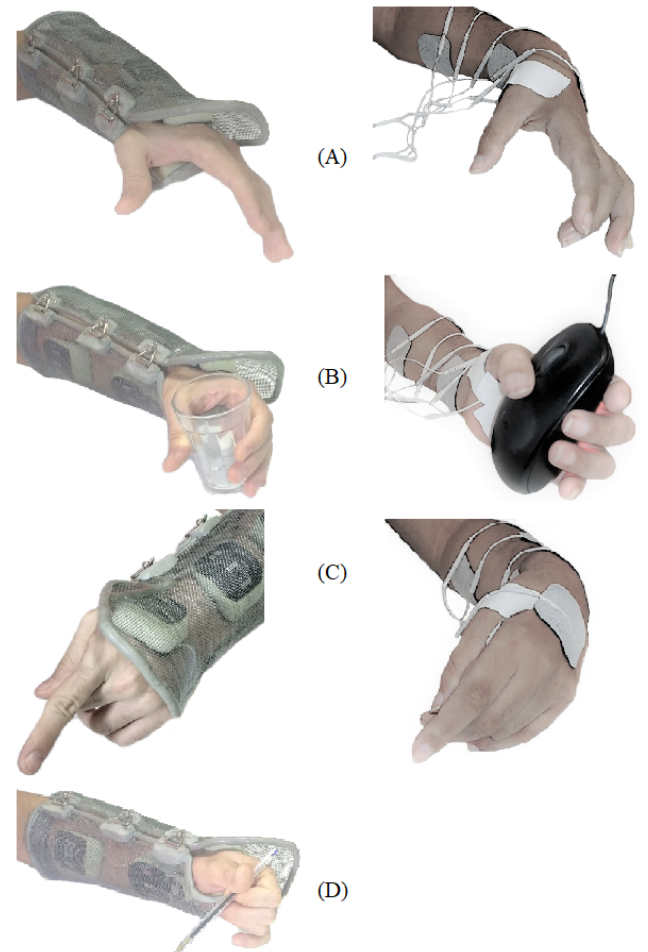
Figure 12. Movements with the applied sequences—able-body individual on the left and SCI in- dividual on the right. ( A ) Hand Opening; ( B ) palmar grasping; ( C ) forefinger extension; ( D ) lat- eral